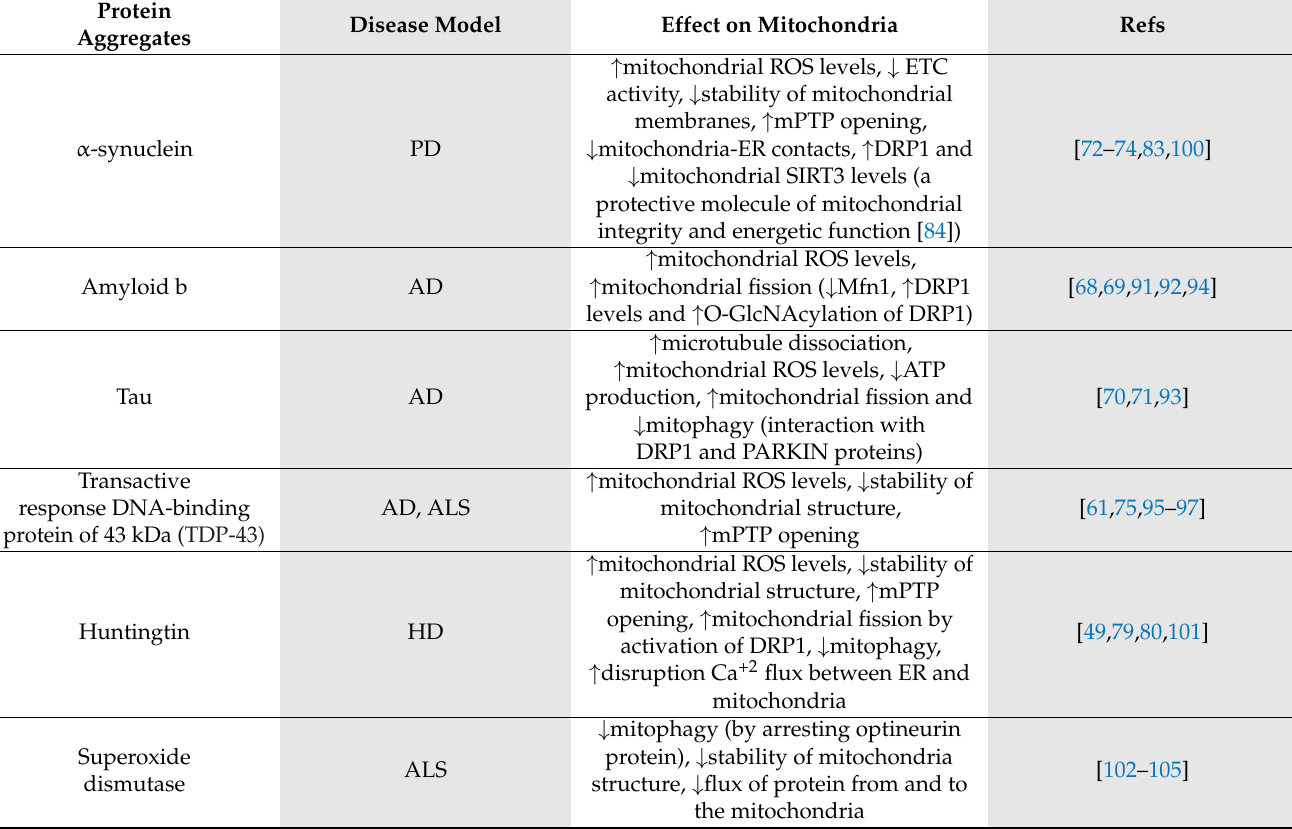
Table 1. Protein aggregates related to mitochondrial dysfunction in models of neurodegenerative diseases.